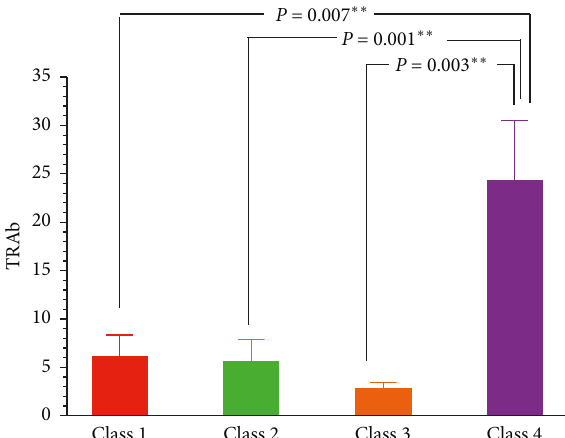
Figure 7: Comparison of the difference of TRAb among the four latent classes. The fourth latent class has a higher TRAb value than other three latent classes. The fourth latent class included GO patients with high abundance of s_Prevotella_copri and g_Bacteroides . ∗∗ P < 0 .